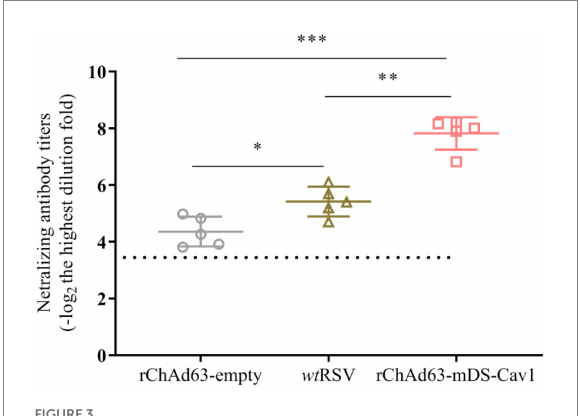
FIGURE 3 Serum neutralizing antibody responses following immunization with rChAd63-mDS-Cav1 in BALB/c mice. BALB/c mice ( n = 5) were immunized intranasally with recombinant adenovirus (1 × 10 10 VP/mouse) or wt RSV (1 × 10 5 PFU/mouse), and serum neutralizing antibody titers were analyzed on day 21 after immunization. Data were shown as mean ± SD, *** p < 0.001.